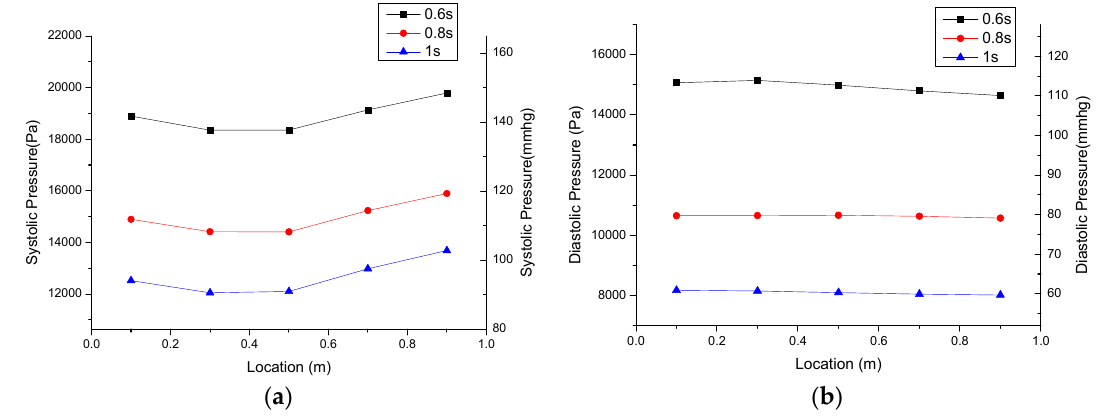
Figure 11. Comparison of pressure in tube under different cardiac cycle ( a ) systolic pressure; ( b ) diastolic pressure.